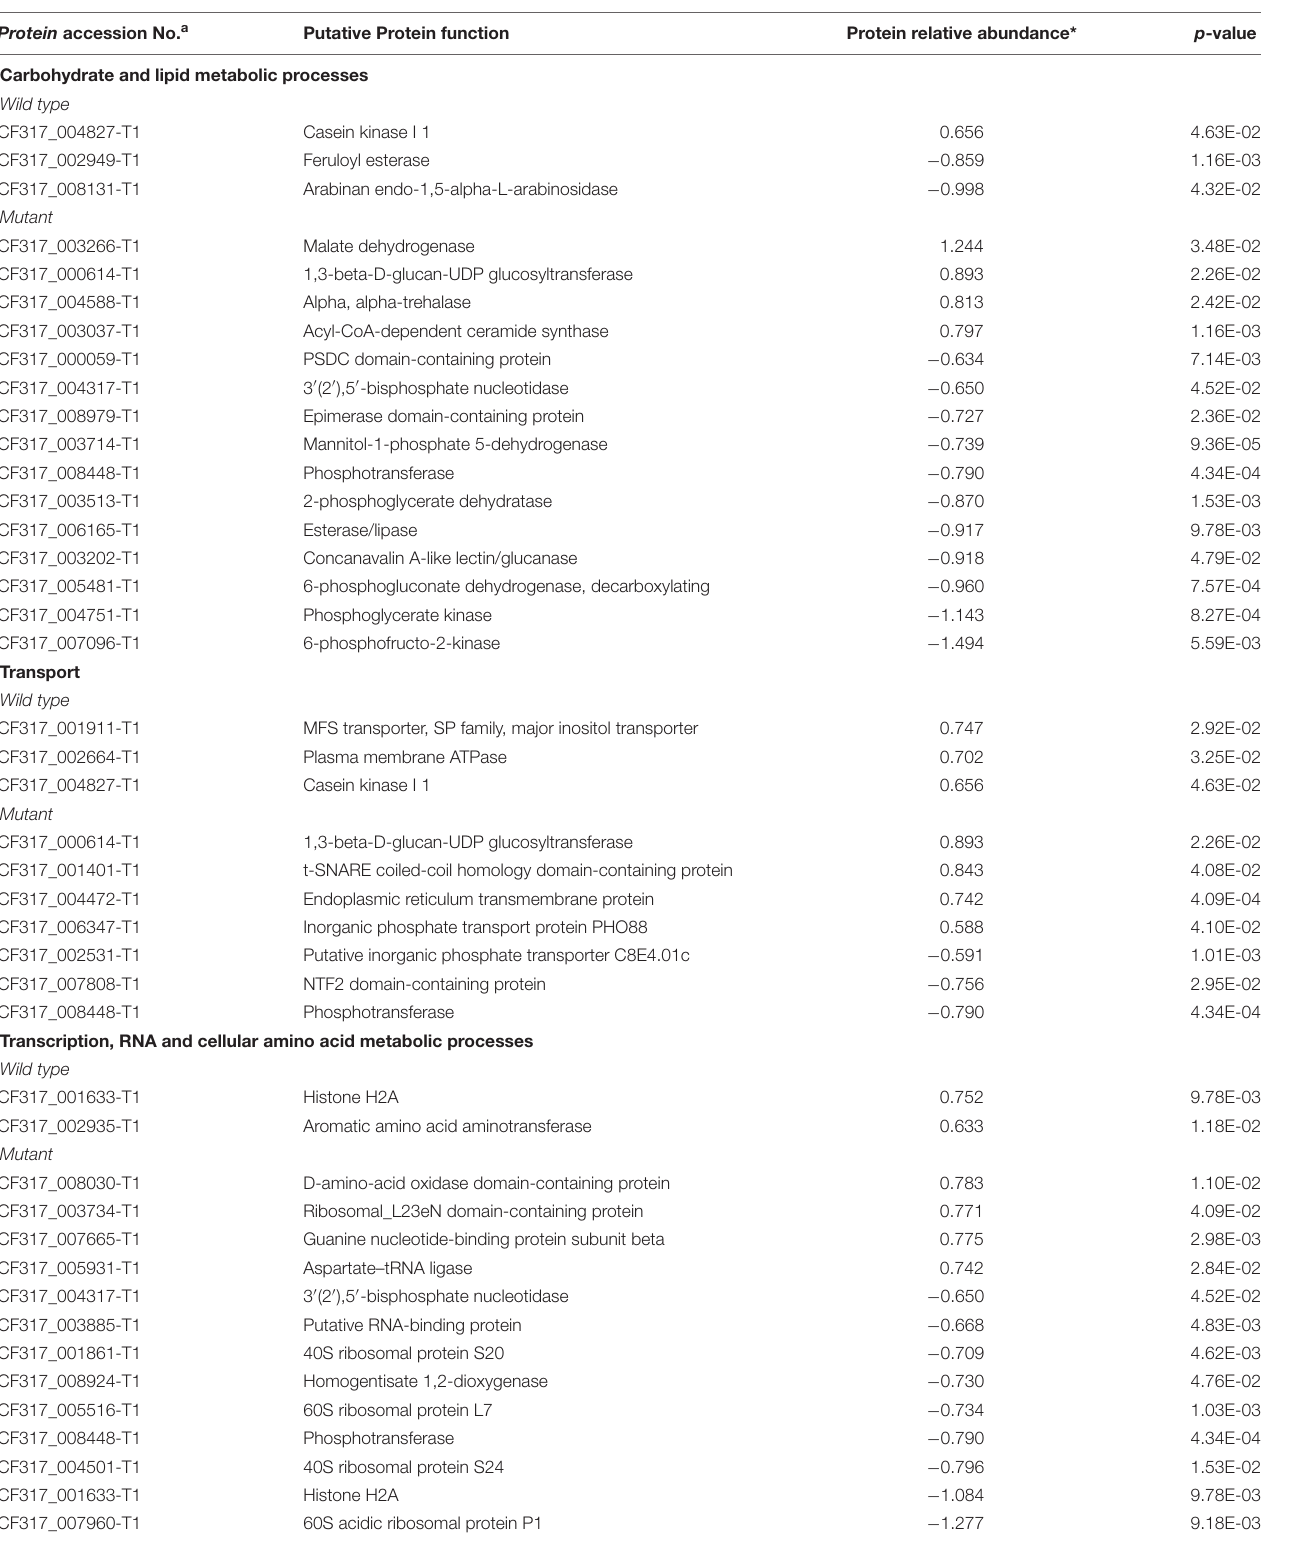
TABLE 2 | Most abundant biological process GO categories regulated under LSSMG in Knufia chersonesos Wt and Mut whole-cell secretome. Differentially expressed proteins included in each category are shown. Protein accession No. a Putative Protein function Protein relative abundance* p